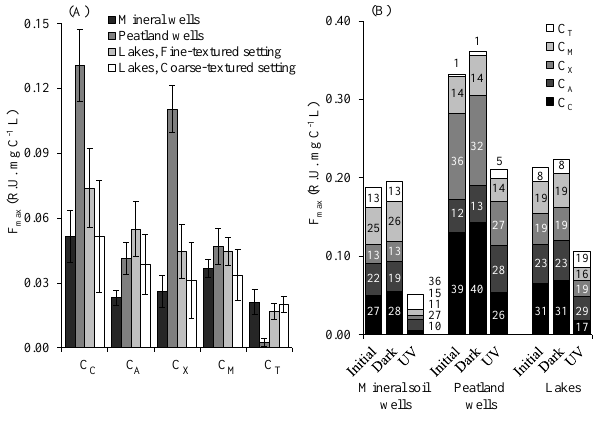
Fig. 3. Maximum fluorescing intensities ( F max ) of the five PARAFAC components for terrestrial DOC sources and lake DOC. (A) Start of incubation PARAFAC component F max for lakes and wells, reporting averages ± 1 standard deviation for 4 mineral wells, 11 peatland wells, 19 lakes in fine-textured settings and 11 lakes in coarse-textured settings. (B) Comparison of average PARAFAC profiles at the start of the incubation versus after 11-day dark and UV incubations. Numbers in or near bars indicate the percent con- tribution of a component to the total fluorescence of all components (i.e. they sum to 100 in each